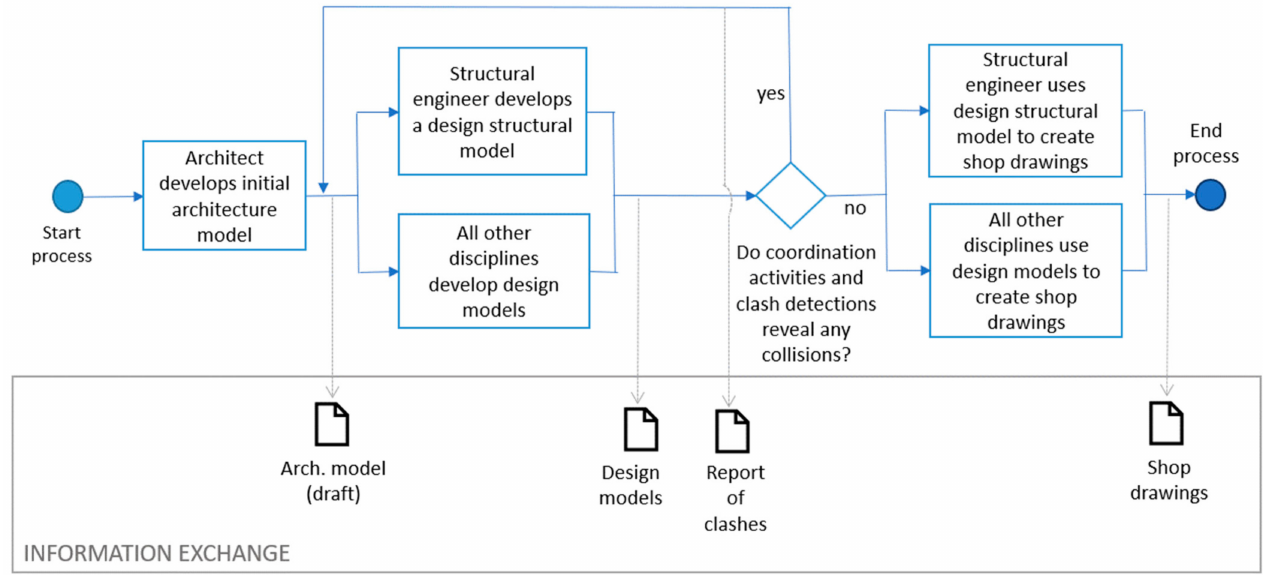
Figure 3. Reference high-level workflow of BIM use (2)—production of shop